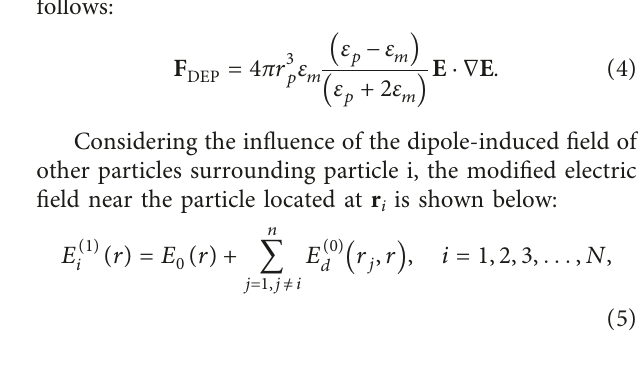
Figure 3: The initial position of two particles are initially equispaced on a circle with θ along x direction, and the final particle chains after DEP interaction under different status: (a) two negative DEP particle, (b) two positive DEP particle, and (c) one positive and one negative DEP